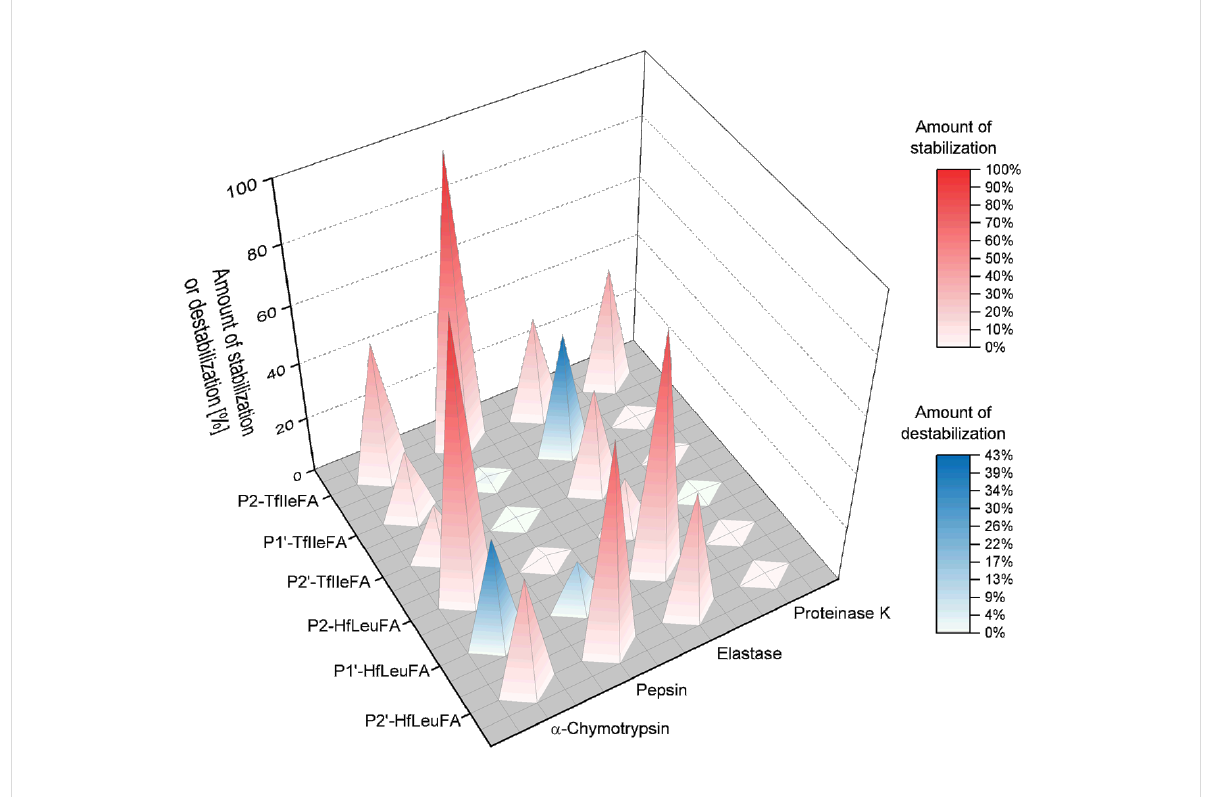
Figure 10: Dimension of stabilization or destabilization upon TfIle or HfLeu incorporation compared to the non-fluorinated analogues containing Ile or Leu, respectively, for all four different enzymes studied here and measured after 24 h of incubation.